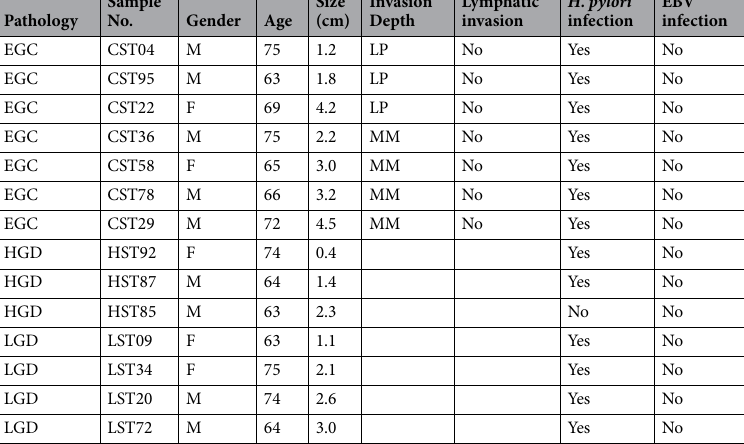
Table 1. Demographics of the discovery